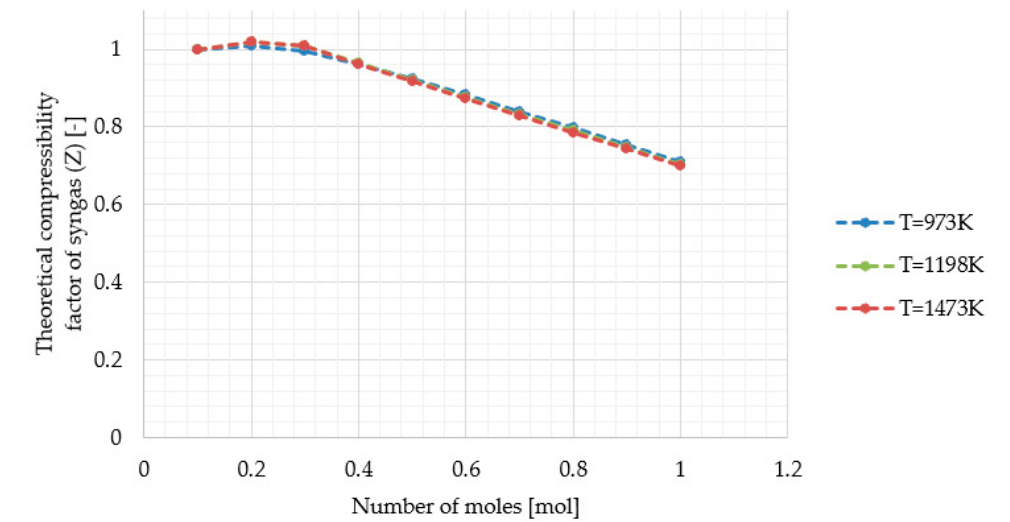
Figure 16. The theoretical value of the compressibility coefficient Z from the gasification of air. During the gasification of SS with oxygen the largest value of the B syn coefficient was 404.61 for one mole of oxygen per mole of carbon at 1473 K. The smallest value of 175.27 was obtained for 0.2 moles of oxygen per mole of carbon at 1473 K. The highest energy content in the transport unit was 47,909.84 MJ for 0.1 moles of oxygen per mole of carbon at a temperature of 973 K, the lowest being 16,025.41 MJ for one mole of oxygen per mole of carbon at 973 K (Figures 17–19).